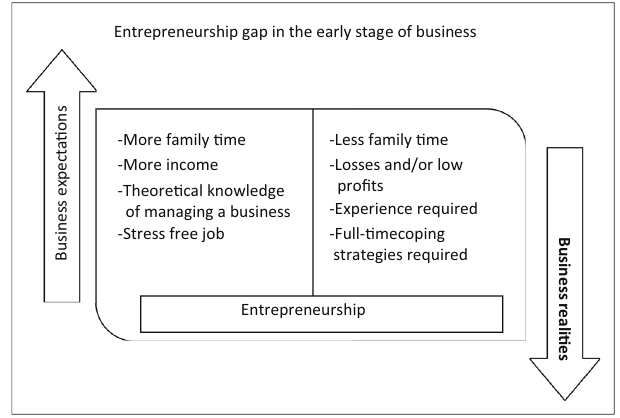
FIG URE 1: Entrepreneurship gap in the early stage.